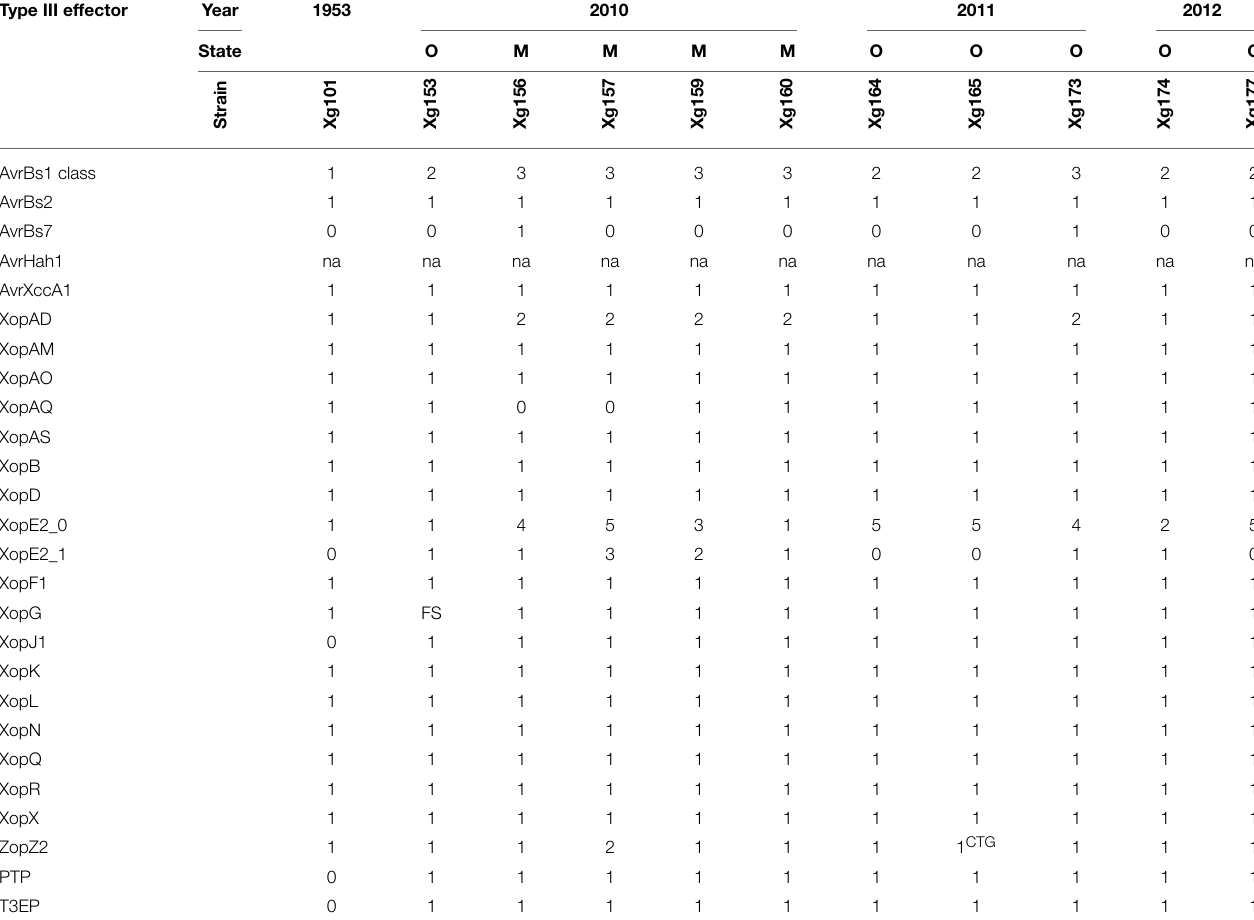
TABLE 4 | Xanthomonas gardneri nucleotide type III effector